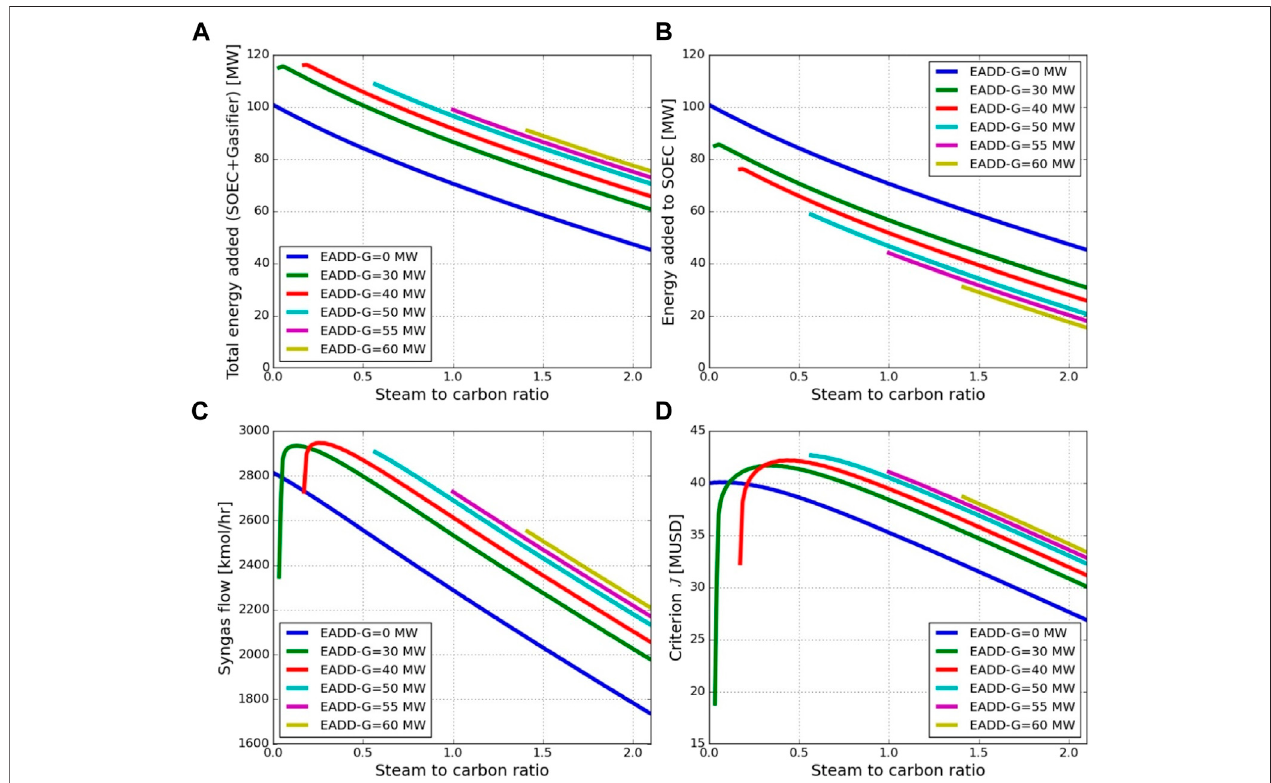
FIGURE 5 | Effect of the steam to carbon ratio and energy added to gasi fi er on (A) the total energy added to the process (SOEC + gasi fi er), (B) energy added to SOEC, (C) amount of syngas (CO + H 2 ) generated, and (D) the criterion de fi ned in Eq. 5.